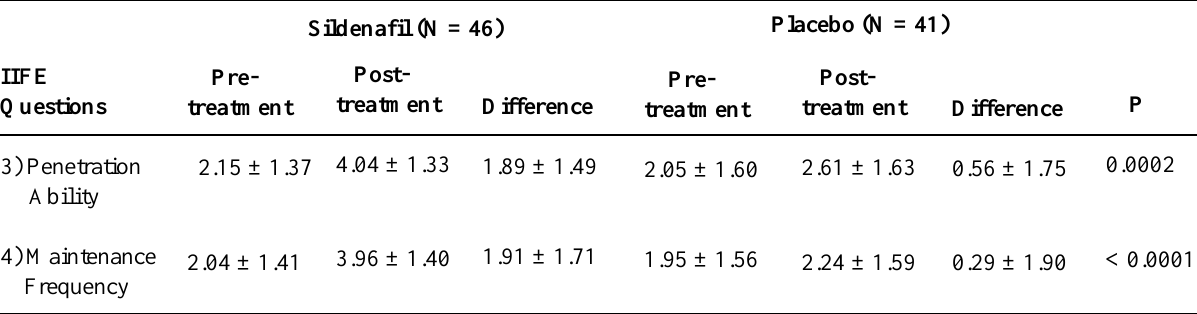
P values refer to comparisons between differences. IIFE, International Index of Erectile